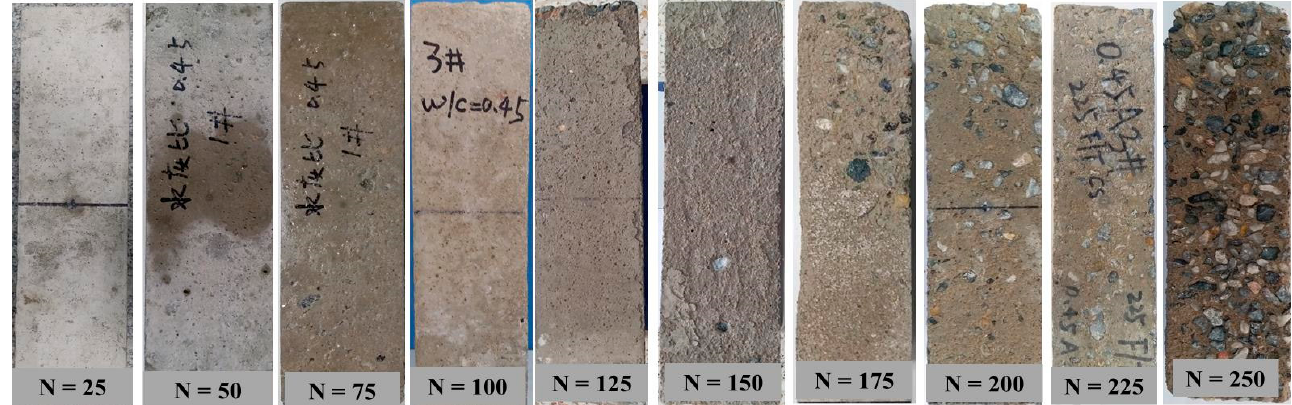
Figure 7. Typical failure characteristics of concrete specimens under different freeze–thaw cycles.